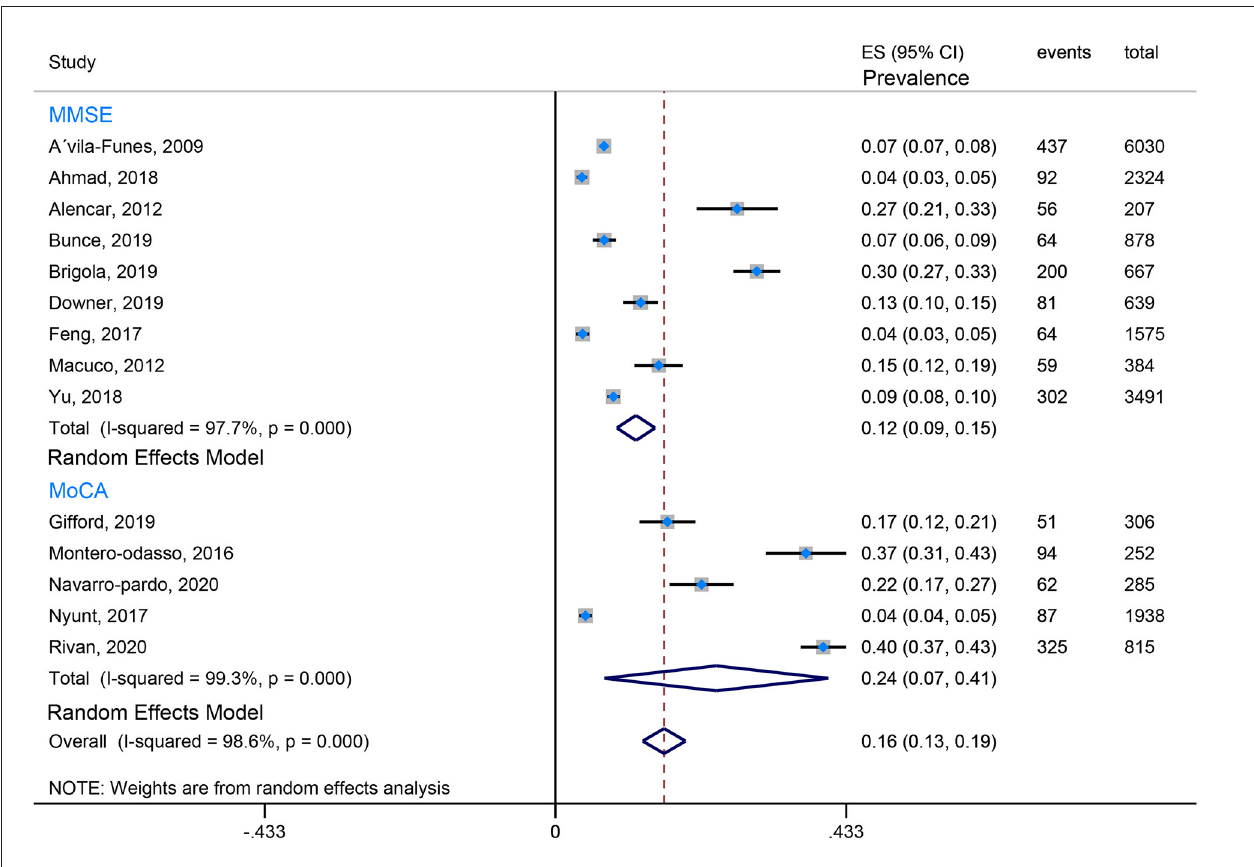
FIGURE 2 | The forest plot pooled the prevalence of CF